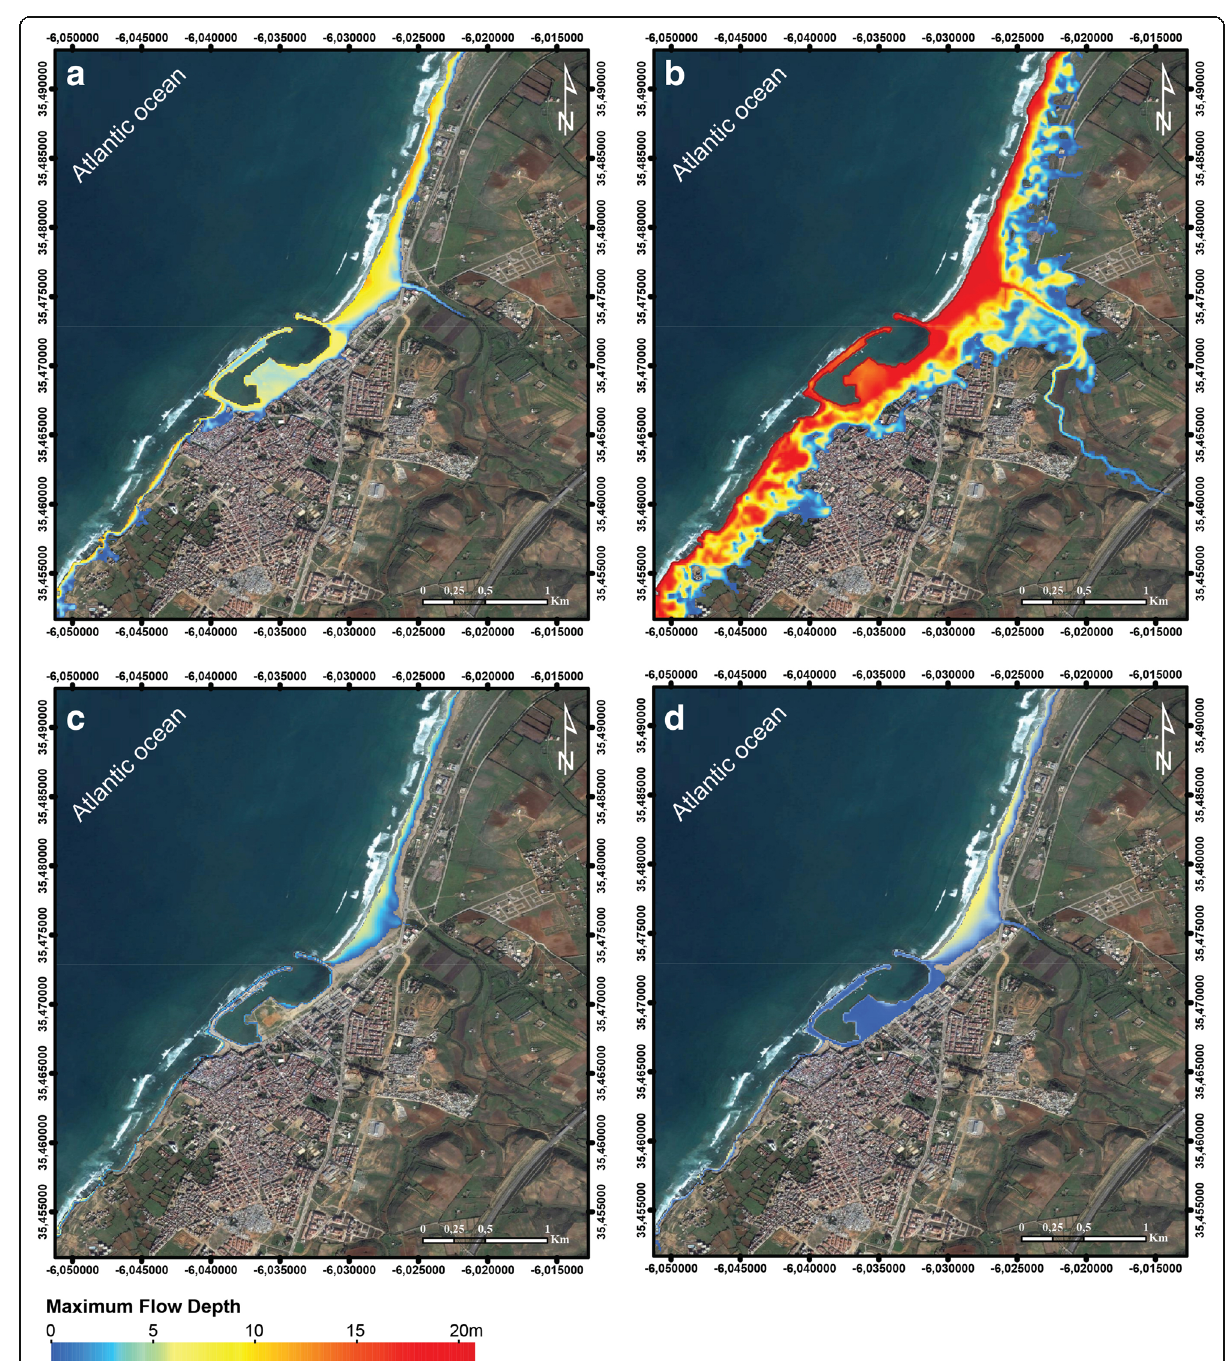
Fig. 4 Results of inundation area and maximum flow depths for each proposed source model of the November 1st 1755 Lisbon earthquake considering MSL condition: ( a ) HSF; ( b ) CWF; ( c ) GBF; ( d ) MPF. MFD are represented by the color bar (in